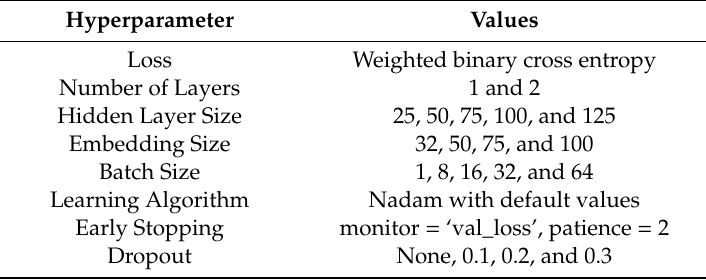
Table 4. Hyperparameter